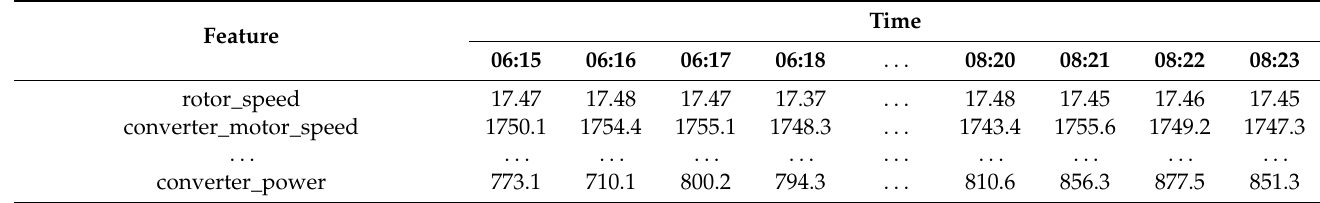
Table 3. Original data of the wind